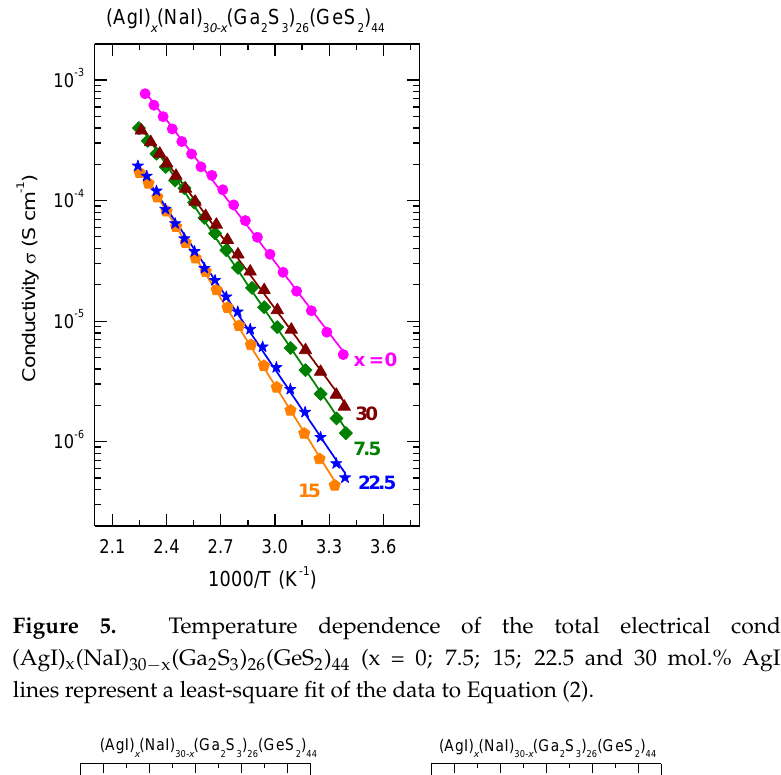
(c) Figure 7. Typical calibration curves for Na + sensors based on ( a ) (NaCl) 15 (Ga 2 S 3 ) 23 (GeS 2 ) 62 , ( b ) (NaI) 15 (Ga 2 S 3 ) 23 (GeS 2 ) 62 and ( c ) (AgI) 22.5 (NaI) 7.5 (Ga 2 S 3 ) 26 (GeS 2 ) 44 glass membranes. 3.2.2. Selectivity Coefficient K Na+,My+ in Standard Solutions The selectivity coefficients of the sensors in the presence of two-valence interfering cations (Mg 2+ , Ca 2+ , Ba 2+ and Zn 2+ ) were determined via a mixed solution method using a